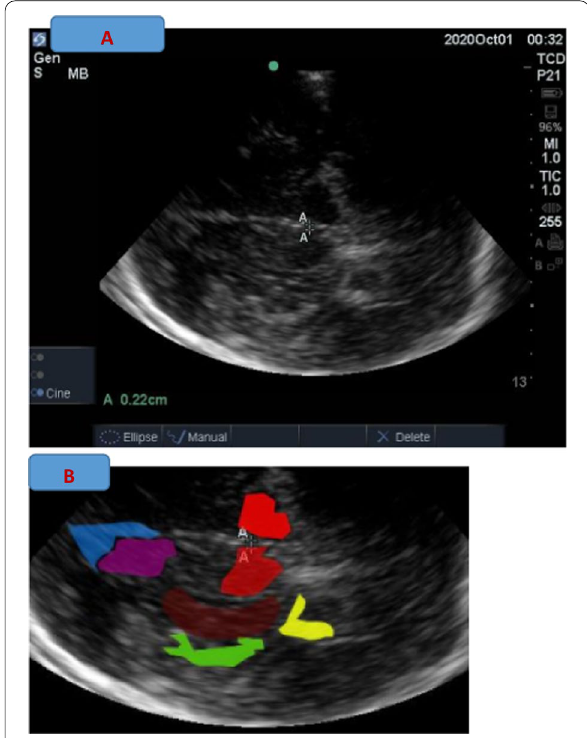
Fig. 3 Anatomy and location of 3rd Ventricle, Frontal and occipital horn, Thalamus, lentiform nucleus and Sylvin fissure. A Temporal window at the level of the thalamus. B A was showed the walls + of the third ventricle, bottom same image with the thalamus in red (usually hypo-echo and located on both sides of the third ventricle), anterior horn of the lateral ventricle in blue, dentate nucleus in purple, occipital horn of lateral ventricle in Yellow, Sylvin groove in green and lentiform nucleus in